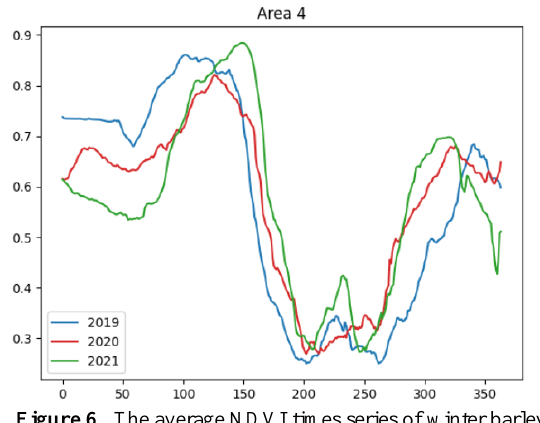
Figure 6. The average NDVI times series of winter barley in Area 4 for three years